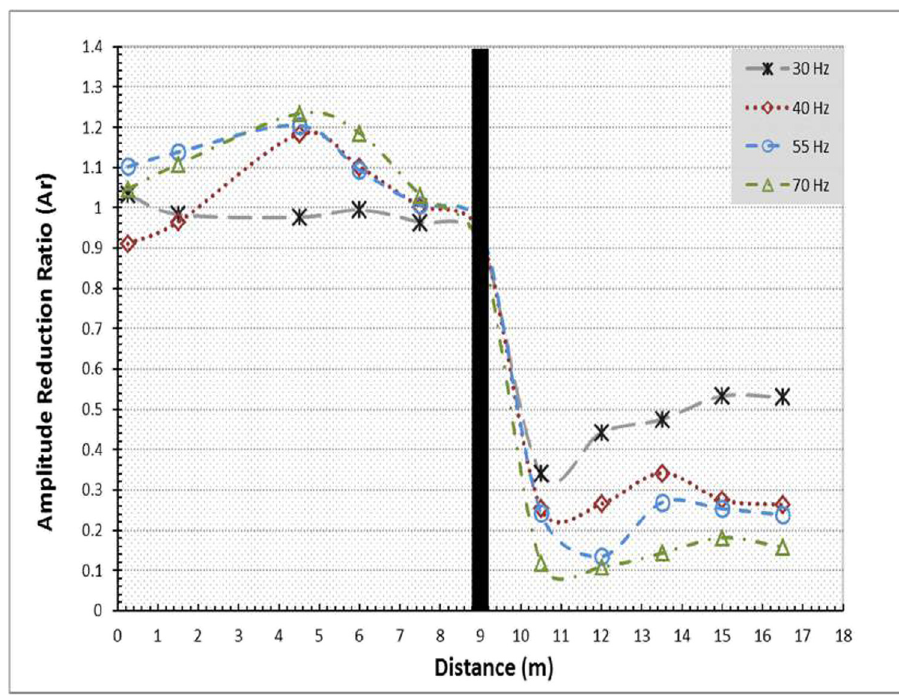
Figure 10: Attenuation of vibration velocity due to an open trench barrier ( passive screening ) .